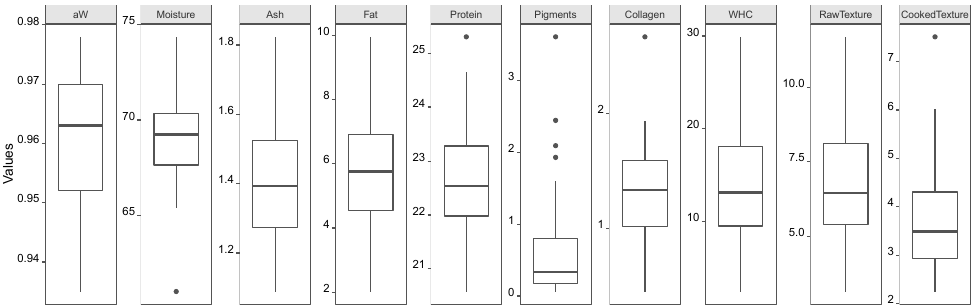
Figure 1. Boxplots of all the dependent variables.